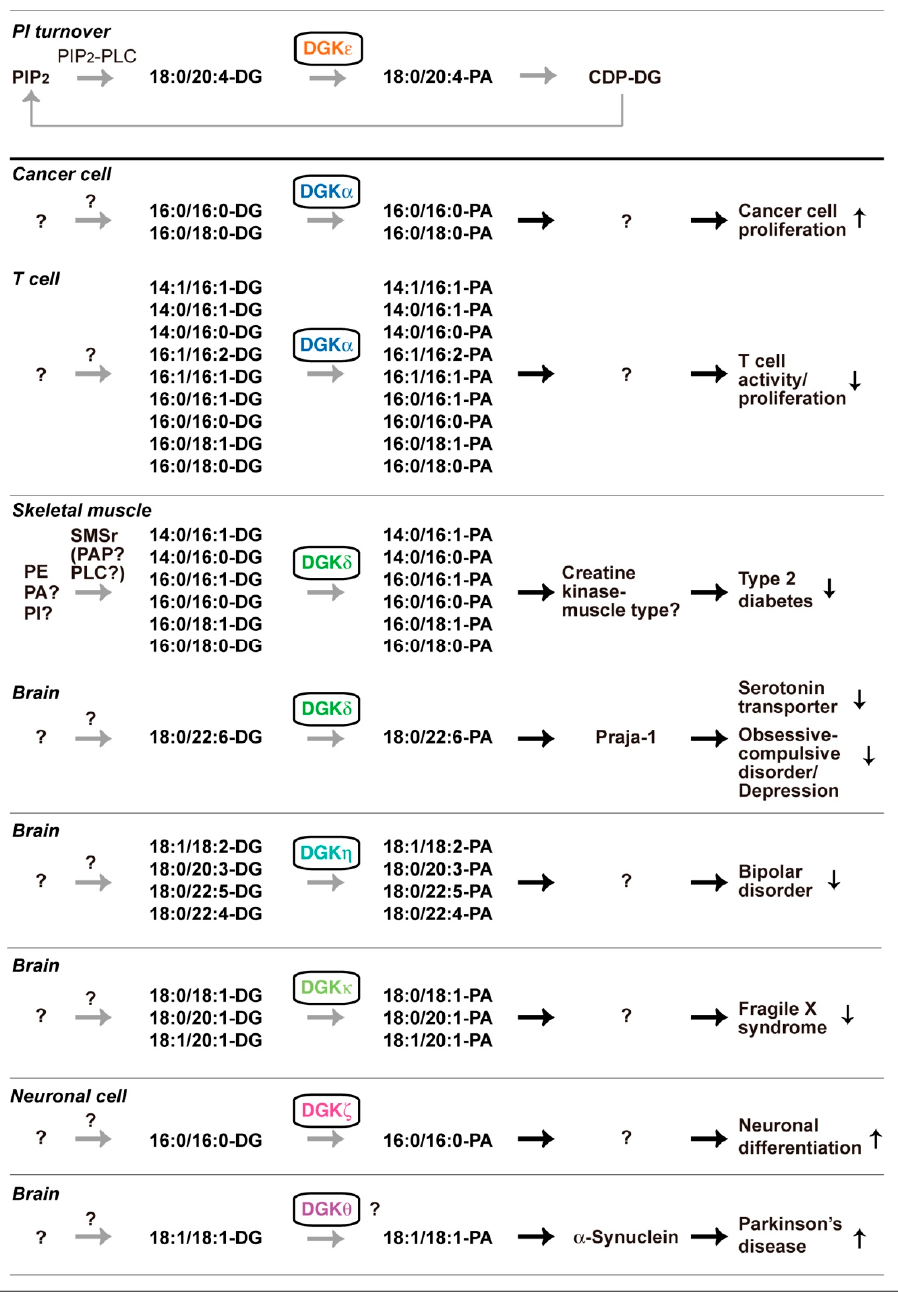
Figure 3. Various DGK isozyme-dependent DG species phosphorylation pathways that are independent of PI turnover. PIP 2 , phosphatidylinositol 4,5-bisphosphate; CDP-DG, cytidine